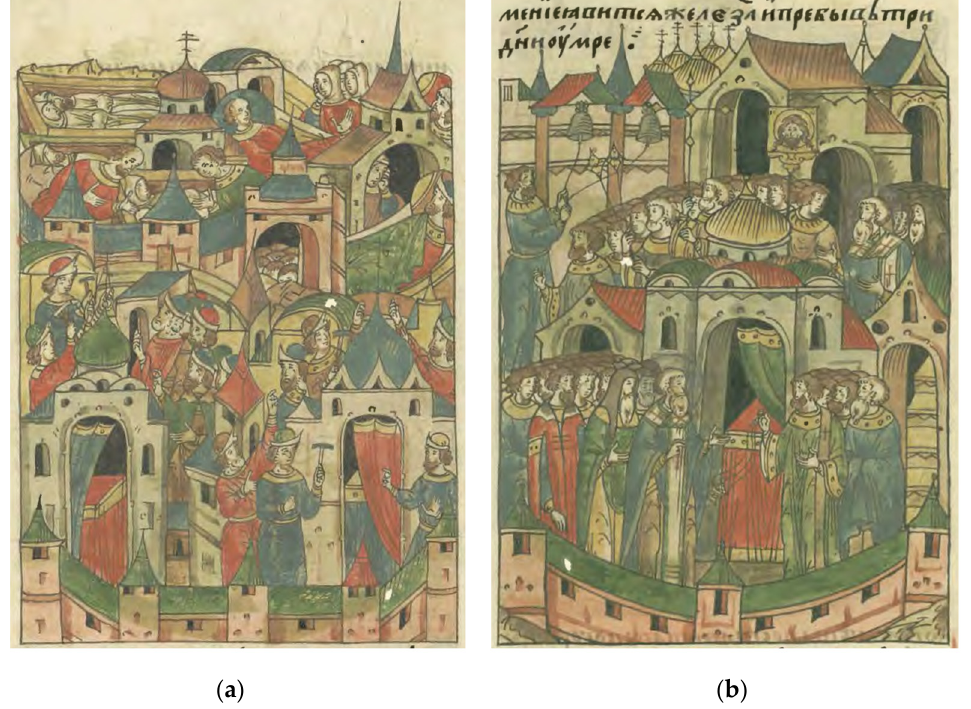
Figure 1. One-day church ritual in Novgorod, 1390. ( a ) Construction; ( b ) consecration. The Illustrated Chronicle of Ivan the Terrible , Osterman Volume II . Library of the Russian Academy of Sciences.